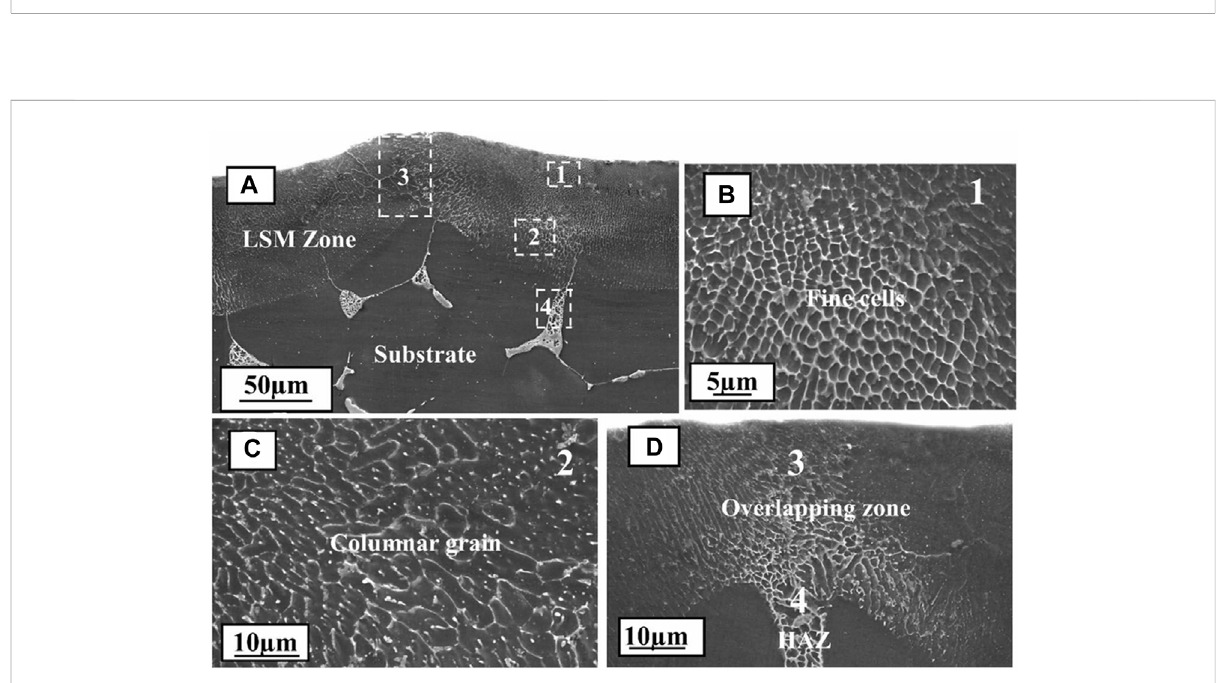
FIGURE 4 Cross-sectional SEM morphology of LSM samples processed: (A) microstructure of the melt pool (Rakesh et al.,